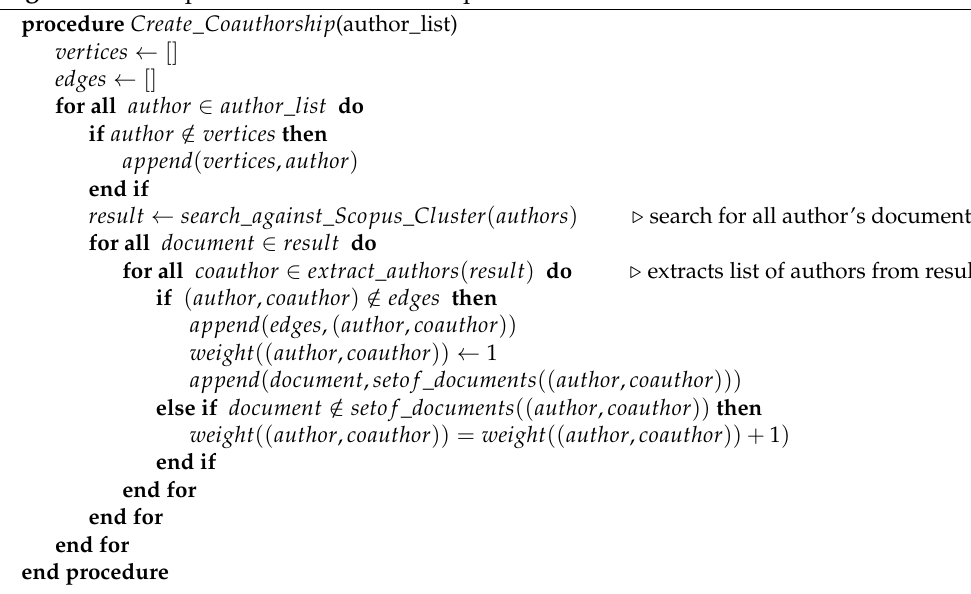
Algorithm 2 Deep first search of common